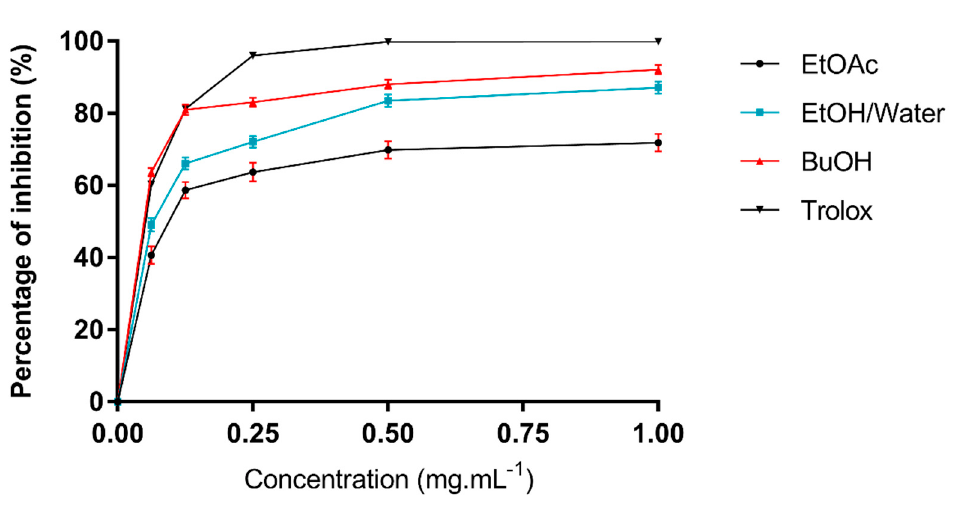
Figure 6. Scavenging activity of A . arboreum leaf extracts on ABTS • + radical compared to the Trolox standard.